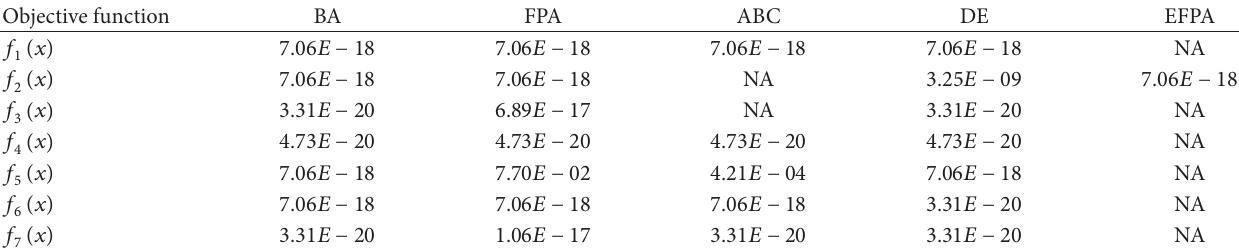
Table 4: 𝑝 -test values of various